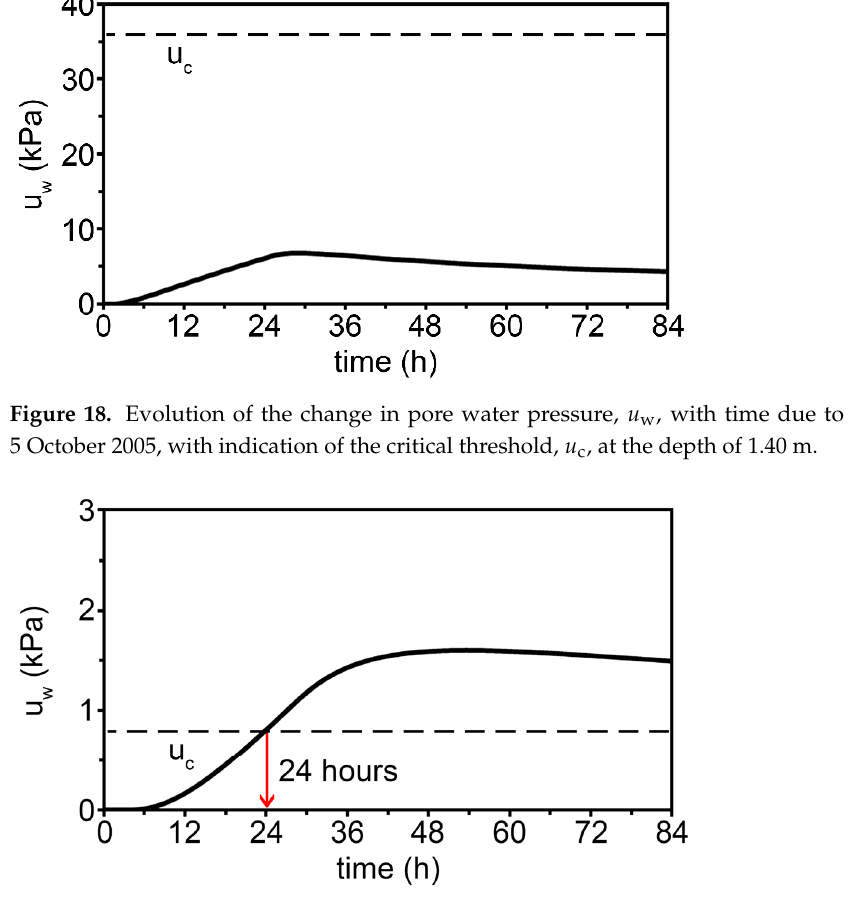
Figure 19. Evolution of the change in pore water pressure, u w , with time due to the rainfall of 1 May 2006, with indication of the critical threshold, u c , at the depth of 1.40 m.